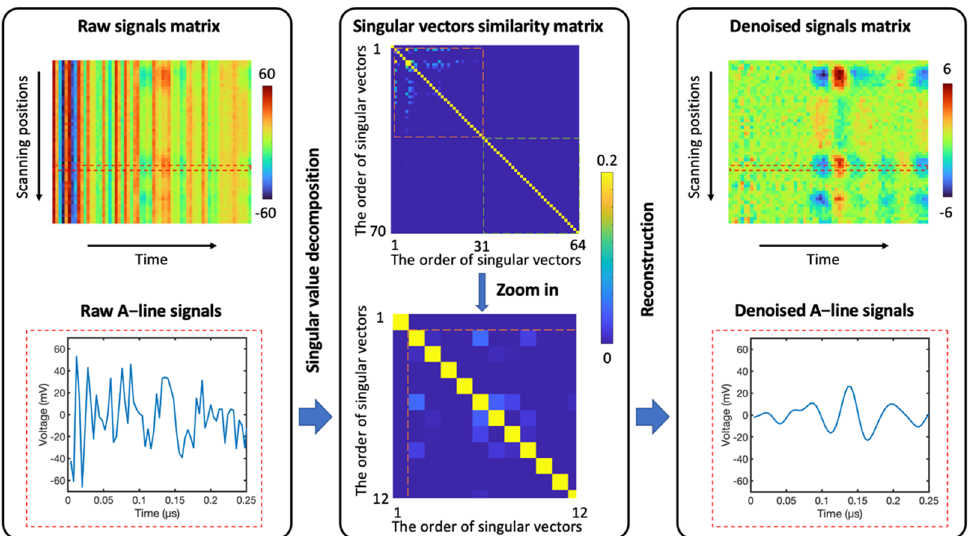
Figure 2. Workflow of singular value decomposition denoising to retrieve photoacoustic signals that were significantly distorted by the trigger-induced noise. A set of A-line signals received by the sensor form a raw signals matrix. After singular value decomposition of this matrix, the correlation coefficients between left-singular vectors are calculated and grouped into three sub-areas. The first sub − area is the first vector which only has coherence to itself and corresponds to the trigger-induced noise. The second sub-area (orange box) contains vectors with coherence to neighborhood vectors and corresponds to photoacoustic signals. The third sub-area (green box) that corresponds to small singular values and shows no coherence to other vectors contains random noises.